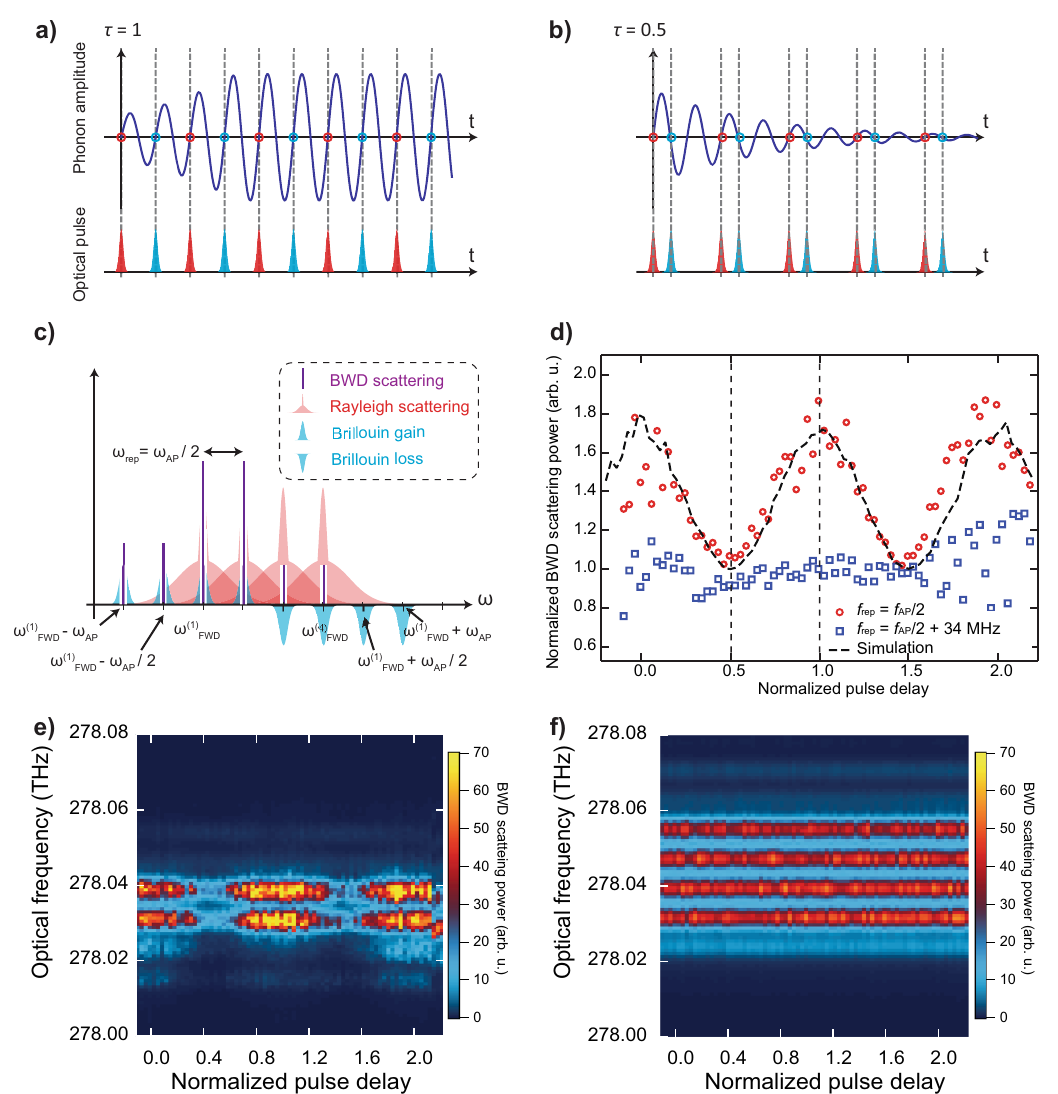
Fig. 3 Conceptual images and results of coherent control of the phonons using double pulses. Time domain pictures for a τ = 1 and b 0.5 delays, respectively. The pulse delay was normalized with respect to the phonon oscillation period. a Growth of the phonon amplitude along the optical pulse train. In contrast, b shows the phonon amplitude, which is excited by the red pulses and damped by the blue pulses. c BWD spectrum when τ = 1. d BWD powers (corresponding to the phonon amplitudes) as a function of the normalized pulse delay τ . Red-circles and blue-square markers represent the experimental þ 2 π ´ 34MHz, respectively. The dashed line represents the simulation results. e , f Show the data with the repetition angular frequencies of ω AP /2 and ω AP 2 optical spectra of the BWD light waves at resonance and when out of resonance,